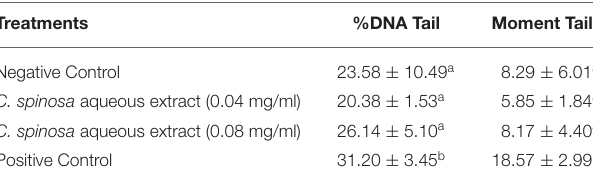
TABLE 2 | %DNA Tail and Moment Tail in Oreochromis niloticus erythrocytes treated with C. spinosa extract, cyclophosphamide (positive control), and fish culture water (negative control).